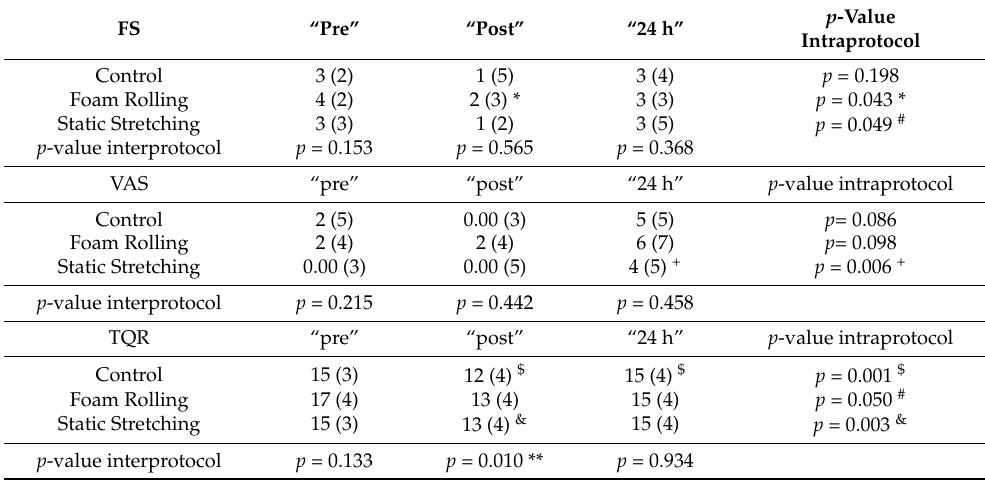
Table 1. Outcomes of the FS, VAS, and TQR presented as median and interquartile